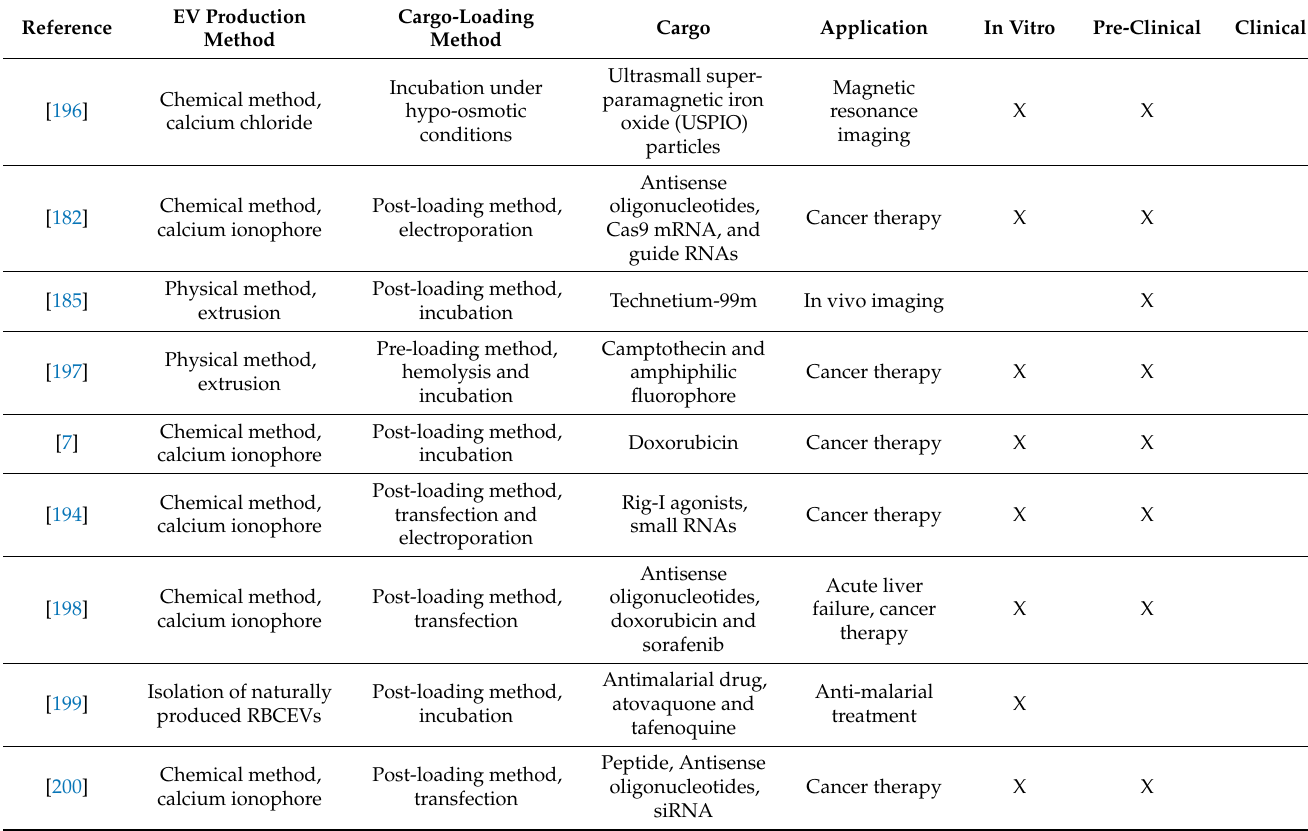
Table 2. Main findings on RBCs-based EVs as a drug delivery